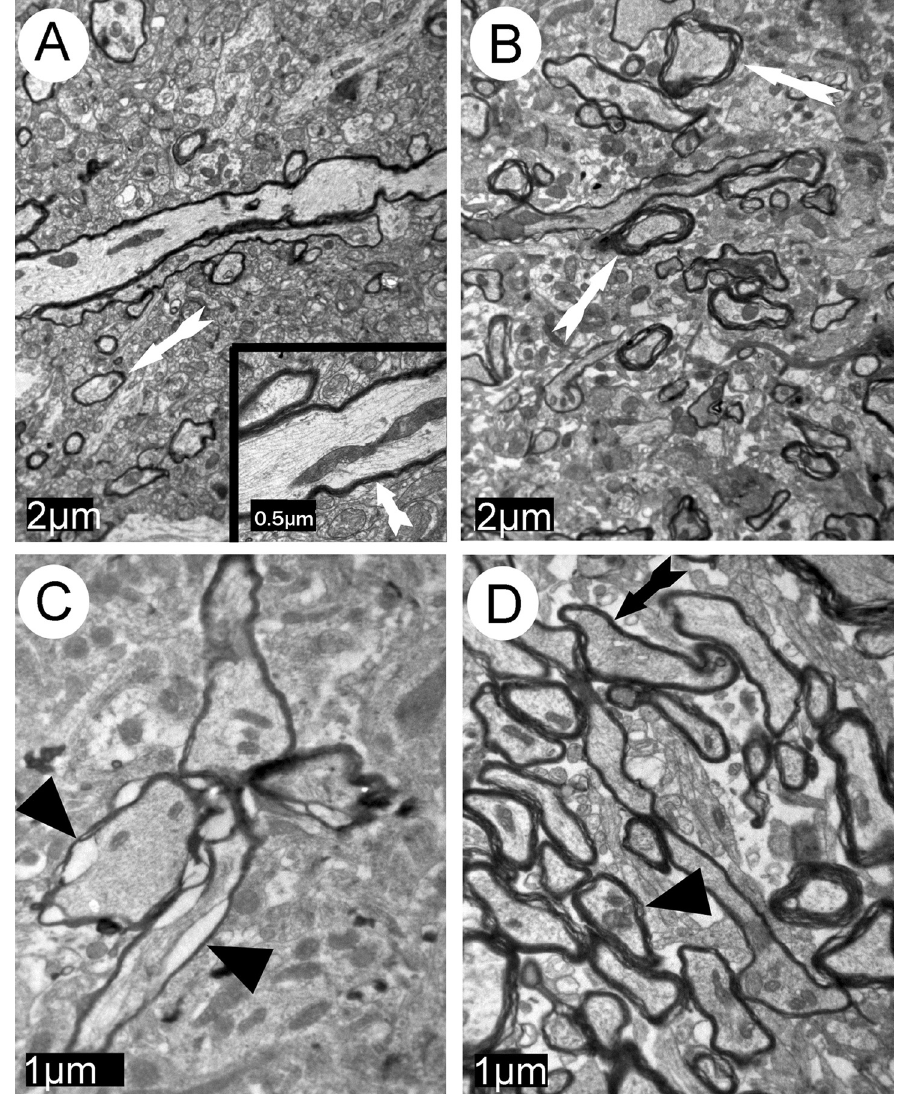
Figure 4. Electron microscopy images of the brain. A , Myelin sheaths in a Sham group rat retained their integrity and were compact (white arrow). Higher magnification is shown in the inset in the lower right corner. B , Myelin sheath in a Saline group rat after hypoxic-ischemic brain damage (HIBD) was characterized by rarefaction and there was obvious separation between lamellae with disordered structure, as indicated by the white arrows. C , Axoplasm shrinkage can be seen in an image from a Saline group rat at higher magnification (black arrowheads). D , Image from a rat injected with mono- sialotetrahexosyl ganglioside (GM1 group) after HIBD shows that, compared to the Saline group, the myelin sheaths are compact and there is less separation between lamellae, as indicated by the black